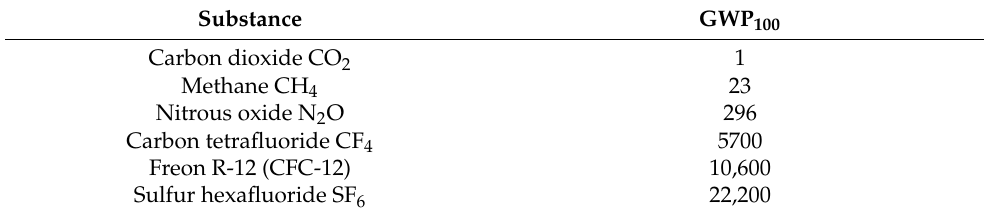
Table 1. Selected chemicals and their GWP 100